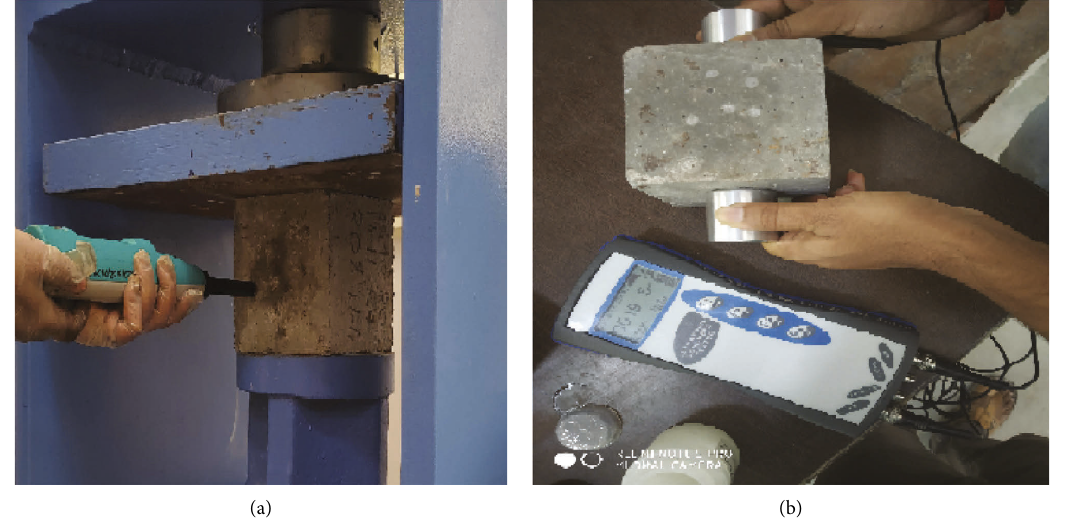
Figure 5: Nondestructive tests pics of (a) rebound strength and (b)